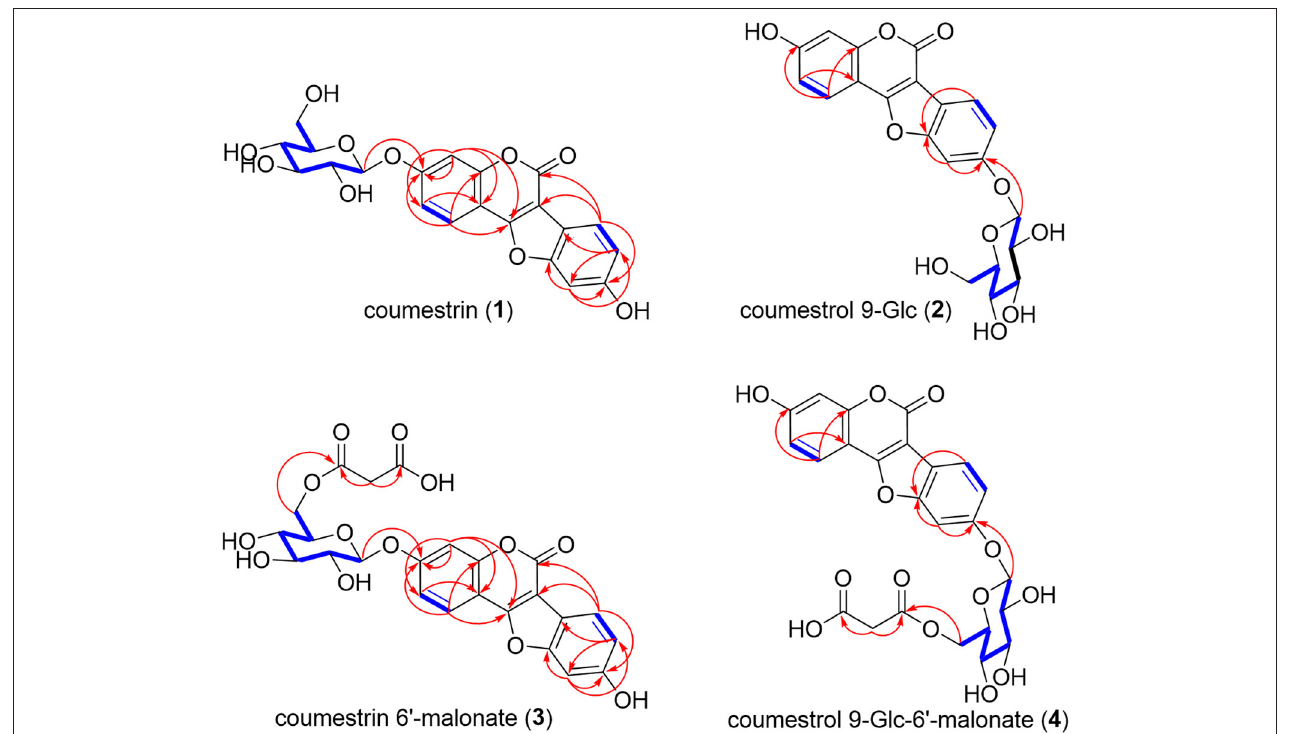
FIGURE 3 | COSY and HMBC for the structural interpretations of coumestrin (CMSN), malonyl CMSN (M-CMSN), and the isomers. 1 H– 1 H coupling and 1 H– 13 C long-range correlations observed in the COSY and HMBC spectra of CMSN (1) , CMS 9-Glc (2) , CMSN 6 ′ -malonate (3) , and CMS 9-Glc-6 ′ -malonate (4) , respectively. The bold blue lines indicate the coupling correlations between the proton and proton signals in the COSY spectrum, and the red arrows show the J 2 and J 3 correlations between the proton and carbon signals in the HMBC spectrum.